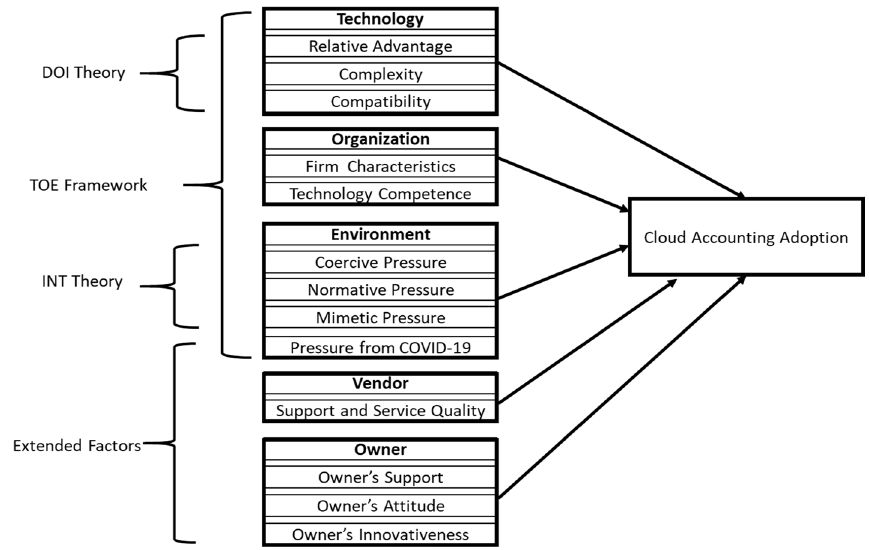
Fig. 1 HYPERLINK "sps:id::fig1||locator::gr1||MediaObject::0" Technology–organization–environment–vendor– owner–cloud accounting adoption framework for small and medium